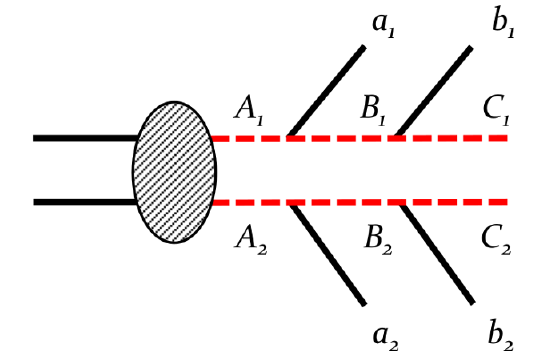
Figure 1 . A schematic depiction of the dilepton t (cid:22) t event topology. Two heavy particles, A 1 and A 2 , are pair-produced, and each A i decays via two successive two-body decays as A i ! a i B i ! a i b i C i . In general, A i , B i and C i are new particles of a priori unknown masses. The two branches are assumed to be identical and the intermediate resonances A i and B i are assumed to be on-shell. The (cid:12)nal state particles a i and b i are visible Standard Model particles which for simplicity will be assumed massless throughout the analysis. The (cid:12)nal state particles C i are invisible in the detector and their momenta are not